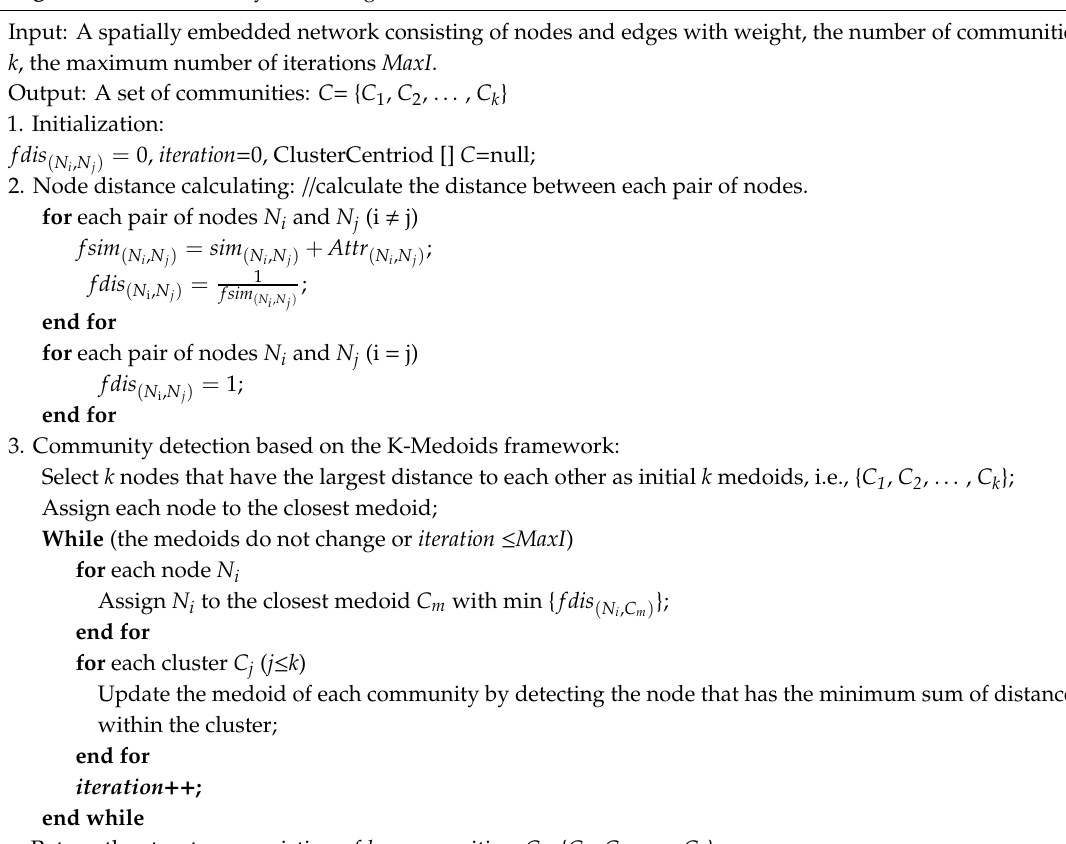
Algorithm 1. Community